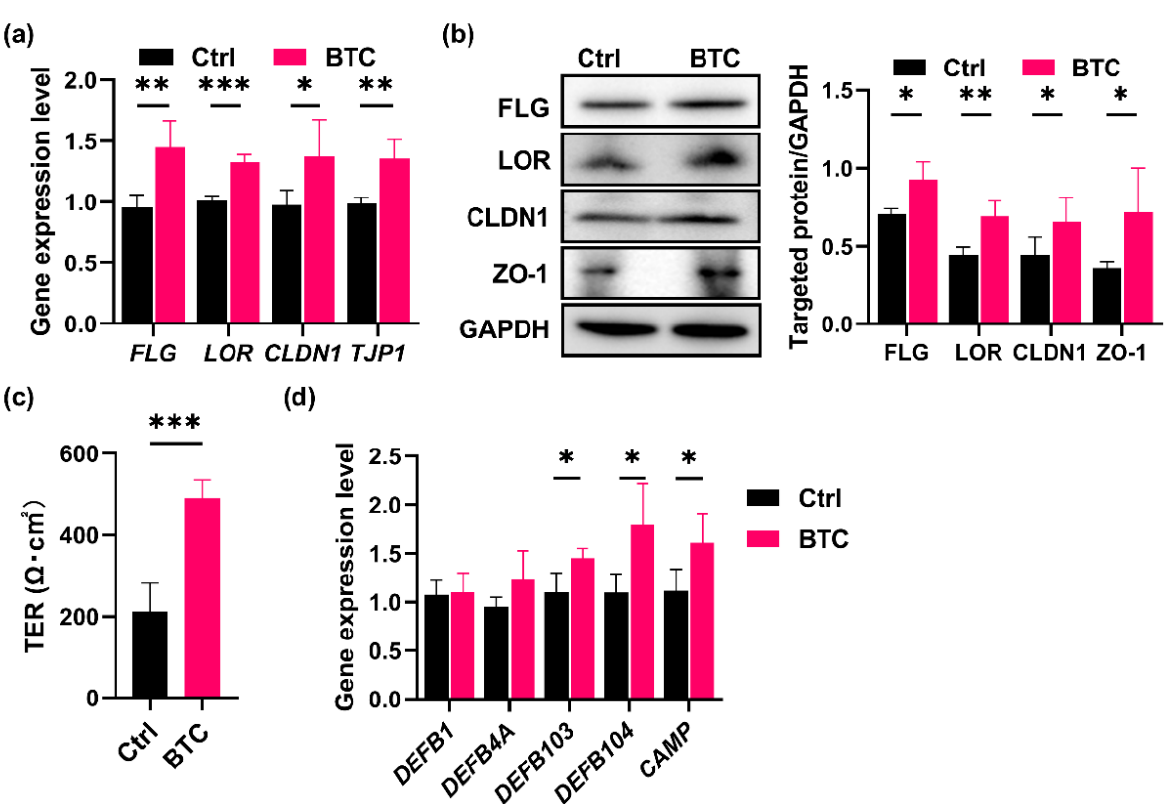
Figure 4. BTC increases the expression of TJ components and skin-derived antimicrobial peptides and improves the TER in keratinocytes. The mRNA expression levels of FLG , LOR , CLDN1 , and TJP1 ( a ); the protein levels of filaggrin, loricrin, claudin-1, ZO-1 ( b ), and TER ( c ); and the mRNA expression levels of DEFB1 , DEFB4A , DEFB103 , DEFB104 , and CAMP ( d ) in keratinocytes with or without BTC administration were detected. n = 3. * p < 0.05, ** p < 0.01, and *** p < 0.001.